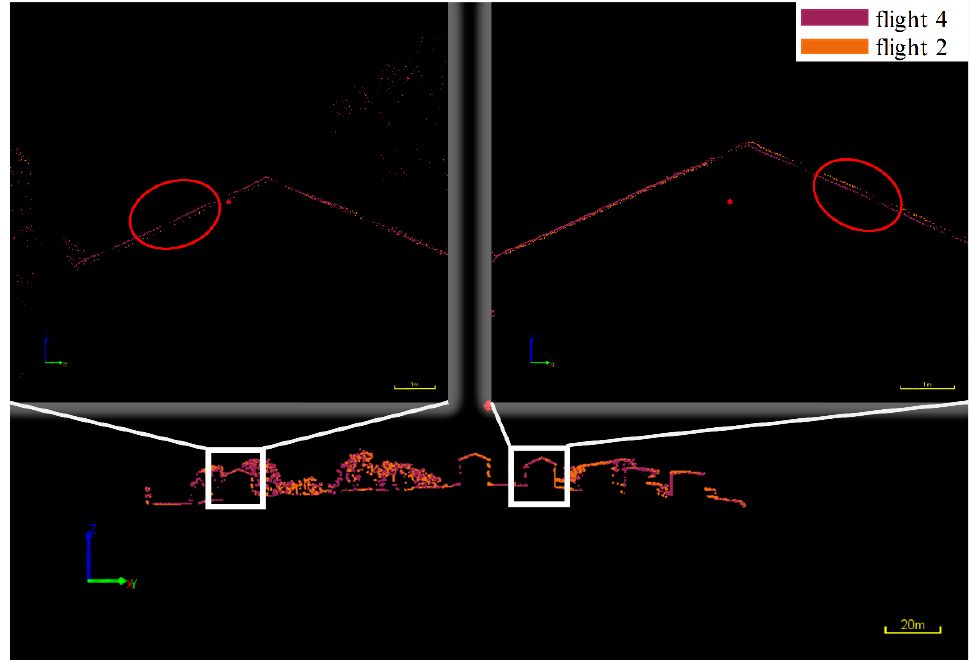
Figure 21. Vertical section of point cloud in isotropic flight strips (flight 2 and flight 4) with installation angle compensation.